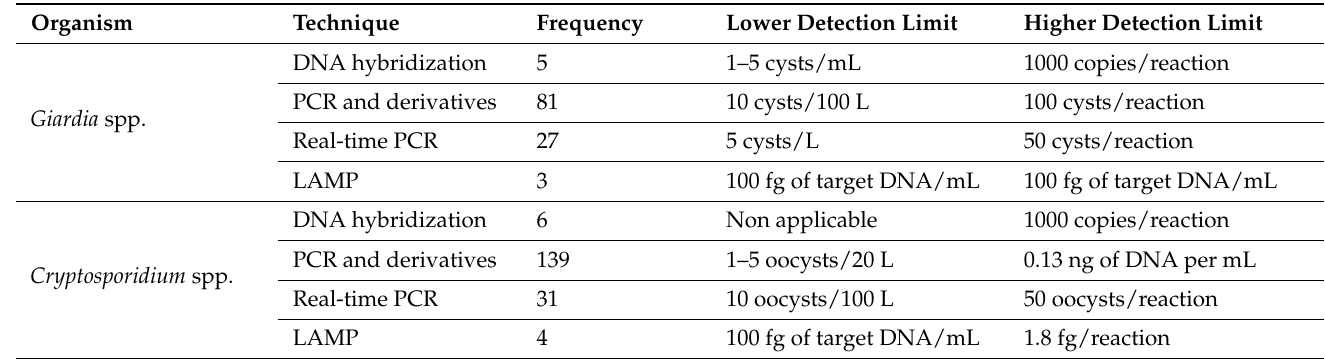
Table 1. Frequency of use of different biomolecular techniques and detection limits achieved. To compare the detection limits retrieved from the literature, the values were converted mathematically into (oo)cysts per microliter. When the detection limit was given in weight instead of in cells, the reference values of 40 fg of DNA per oocyst and of 313 fg of DNA per cyst were used for the conversion, as stated in [101,102]. Also, since Giardia is a polyploid organism and thus the number of genome copies varies between cells, one genome copy per nucleus (four copies per cyst) was assumed to simplify the conversion. Finally, to standardize the limits of detection, the volume of the reaction was systematically assumed to be of 1 µ L for more